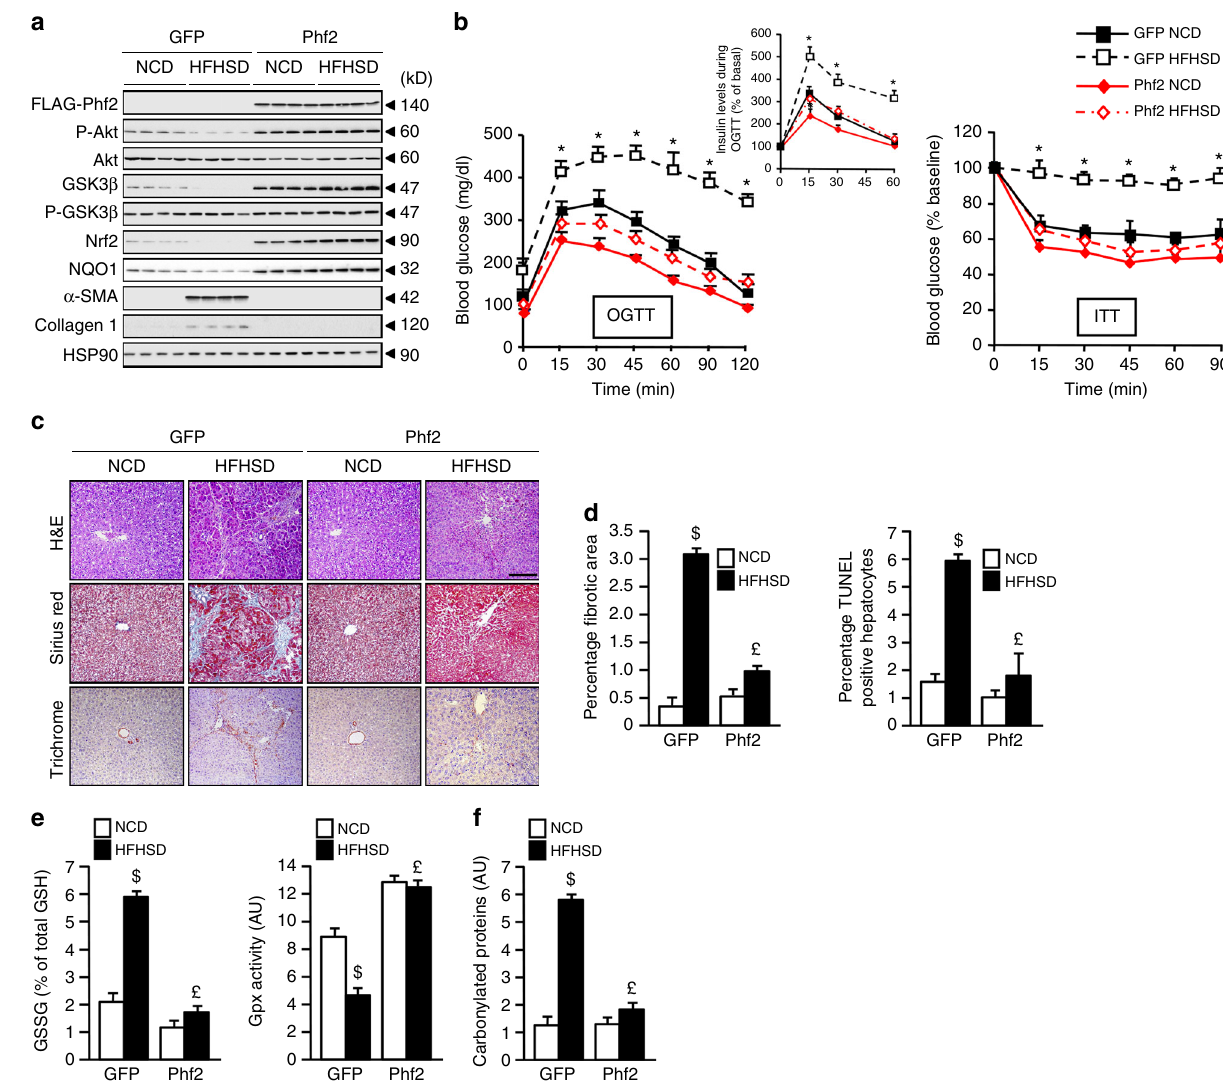
Fig. 8 Phf2 protects the liver from high fat and high sucrose diet-induced fi brogenesis during obesity. GFP or Phf2 were overexpressed through AAV strategy speci fi cally in the liver of 7-week-old male C57Bl/6 J mice. Mice were then fed with either a chow diet (NCD) or with a high fat and high sucrose diet (HFHSD) for 16 weeks. Mice were studied in the fed state. a Representative western blot analysis showing the contribution of Phf2 overexpression to the regulation of the PI3K/Akt signaling and pro- fi brogenic pathways in liver extracts ( n = 15 per group). b (Left) Oral glucose tolerance test and insulin levels during the OGTT test. (right) Insulin tolerance test ( n = 15 per group). c Liver sections stained with hematoxylin and eosin (H&E), trichrome masson and sirius red are shown. Scale bars = 100 μ m ( n = 10 per group). d Percentage of fi brotic area and percentage of apoptotic hepatocytes ( n = 15 per group). e Relative oxidized GSSG content and measurement of Gpx activity ( n = 10 per group). f Levels of carbonylated proteins ( n = 10 mice per group). All error bars represent mean ± SEM. Statistical analyses were made using unpaired t -test ( b ) or Anova, followed by Bonferonni ’ s test ( d, e ). * P < 0.01 HFHSD/GFP compared to HFHSD/Phf2, $ P < 0.01 HFHSD/GFP compared to NCD/GFP, £ P < 0.01 HFHSD/Phf2 compared to